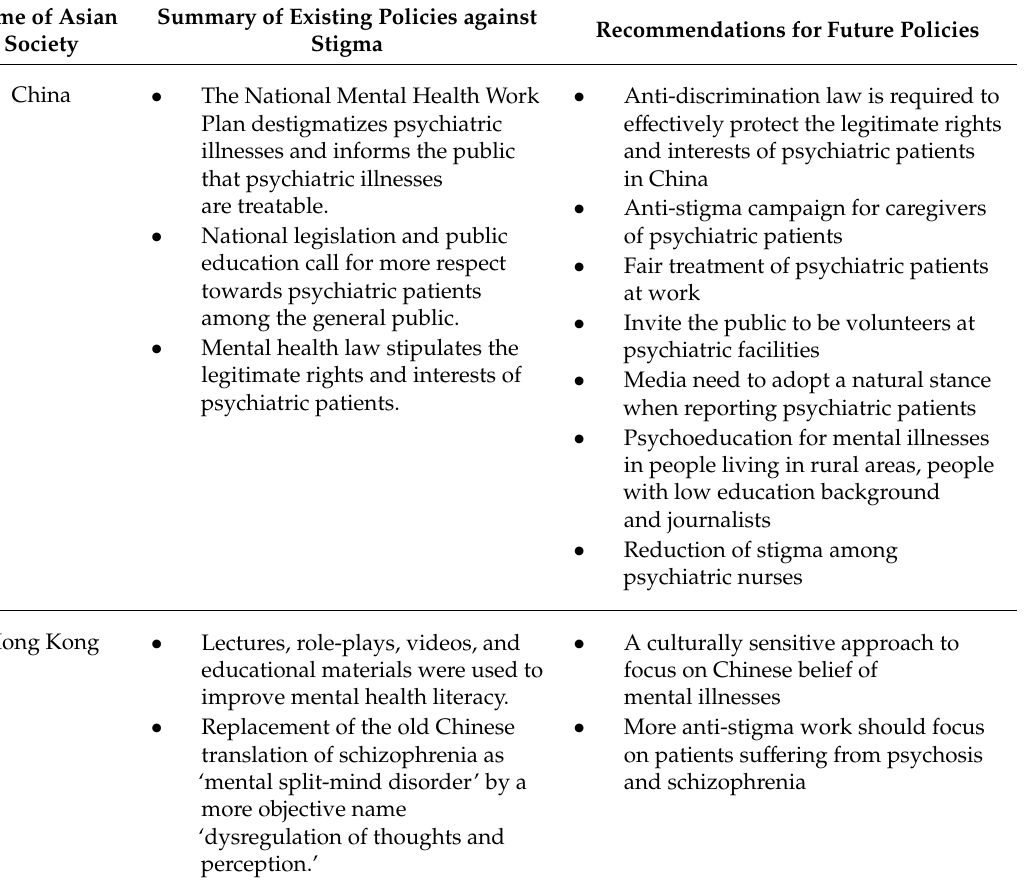
Table 1. Summary of existing policies against stigma and recommendations for future policy in six Asian